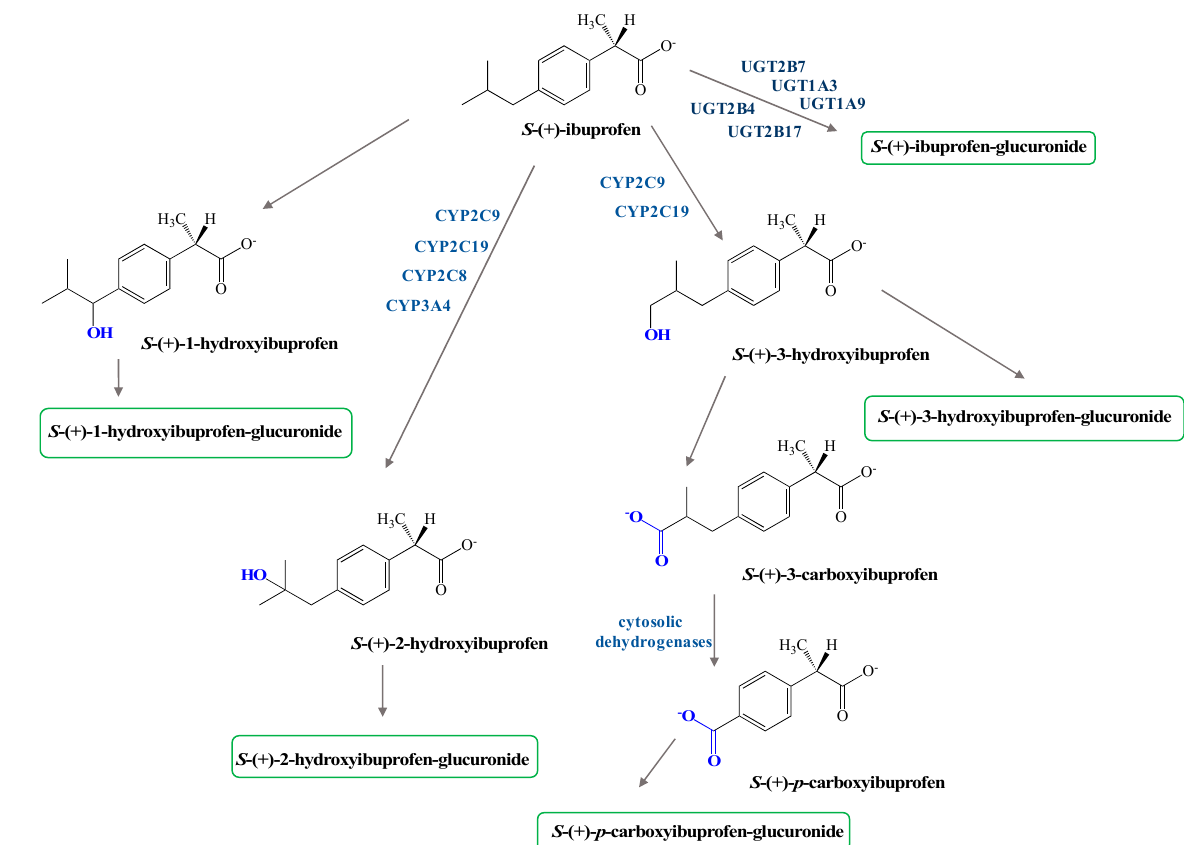
Figure 2. Oxidative metabolism of S -(+)-ibuprofen (UGT–uridine 5 ′ -diphospho-glucuronosyltransferase; CYP–isoforms of cytochrome P450).